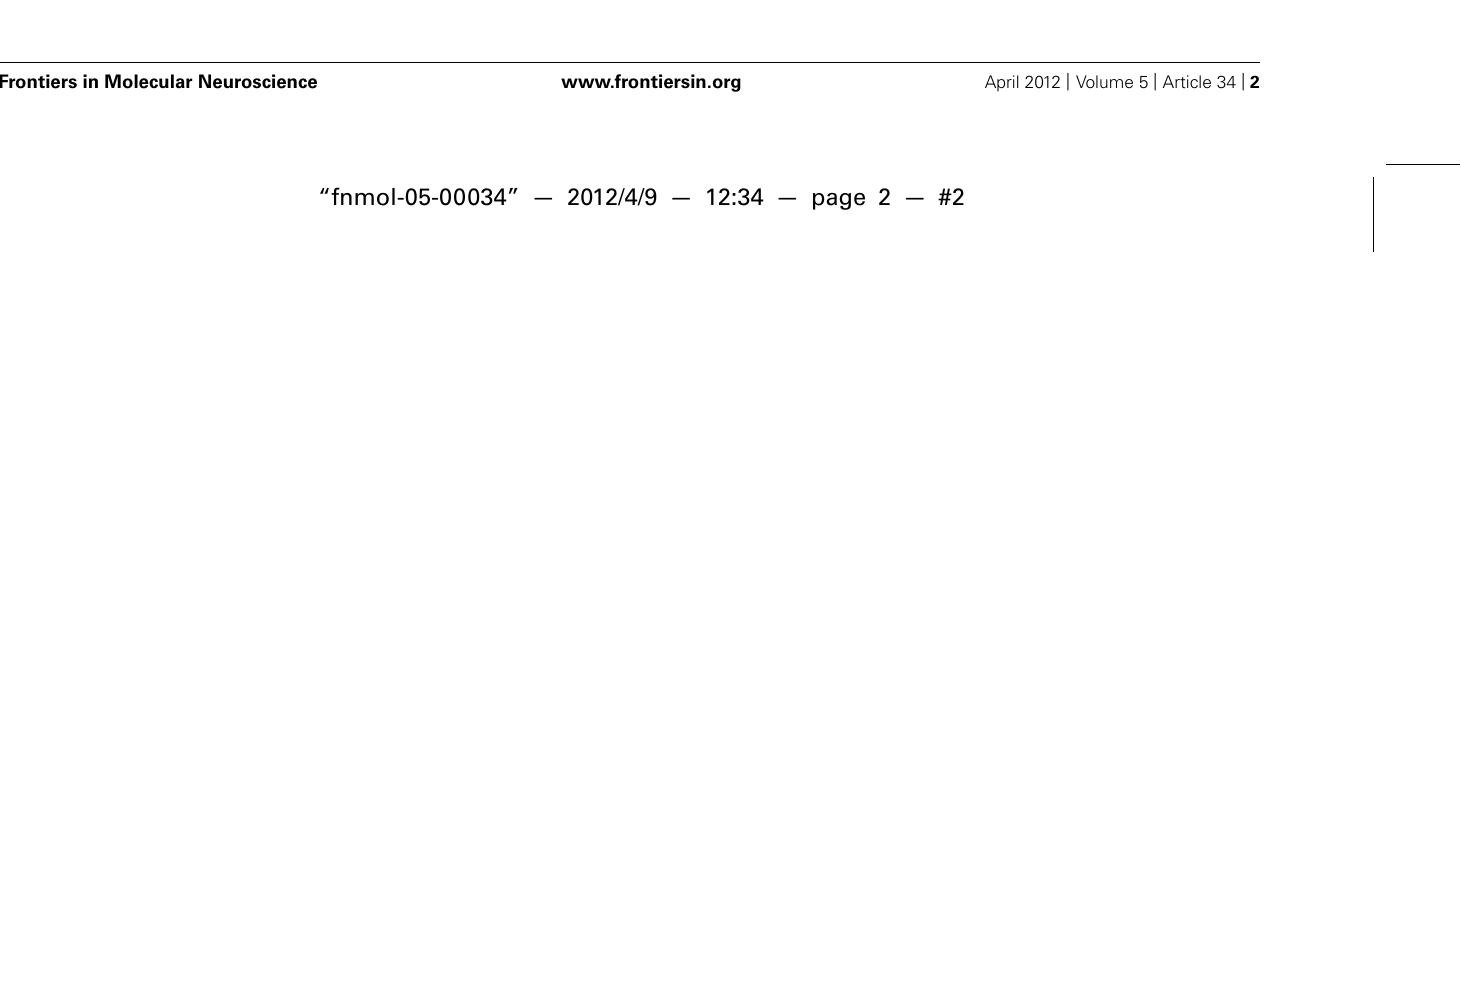
Ca 2 + -permeability of the AMPA receptor site and is located in the putative second membrane domain.The R/G site and flip/flop sites, which control desensitization of the receptor, are located prior to the fourth membrane domain.The protein sequence of GluA2 varies by one codon, arginine (Arg), from GluA1, GluA3, and GluA4, which express a glutamine (Gln).The arginine is post-transcriptionally introduced by an amino acid change in the pre-mRNA of GluA2 by RNA editing. (D) Current response in normal Ringer solution and Ca 2 + -Ringer solution of oocytes injected with GluA1 cRNA (left) or GluA1 + GluA2 cRNA (right). Oocytes containing GluA2 eliminated the inward current, thus showing GluA2 regulates Ca 2 + -permeability of the AMPA receptor. Reprinted from Hollmann etal. (1991), with